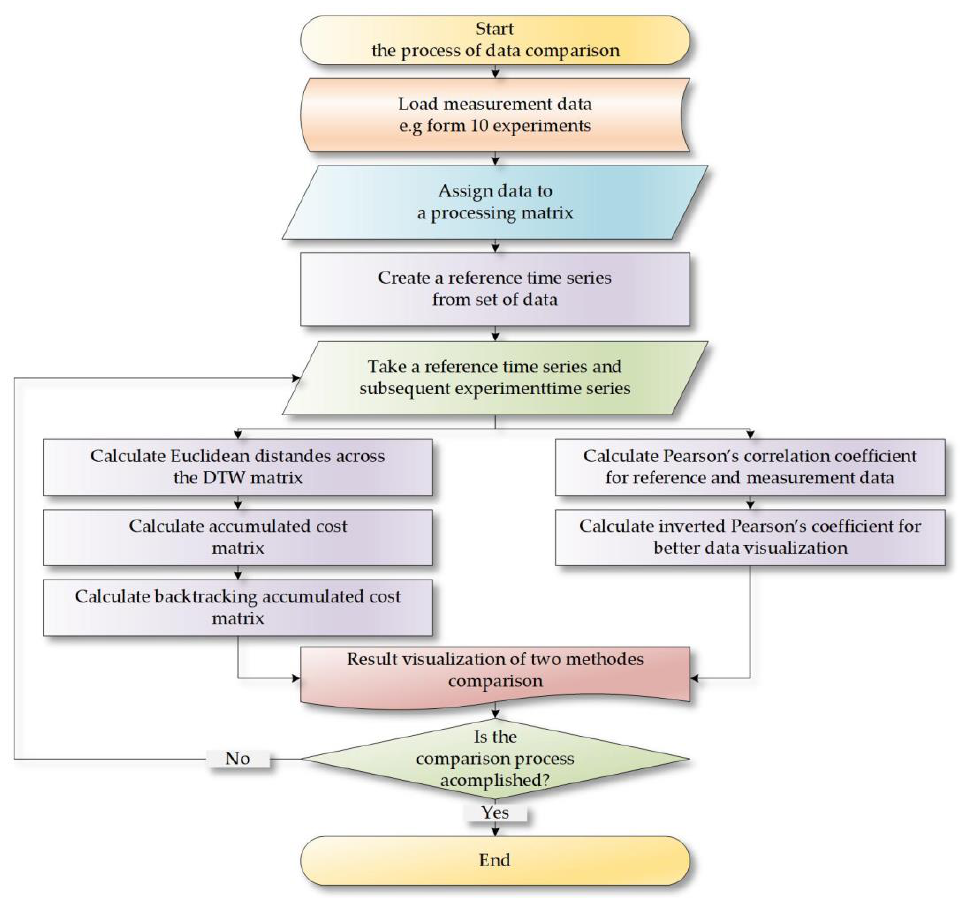
Figure 7. The algorithm of the procedure in which a magneto-inductive flowmeter and a uroflowmeter were compared.